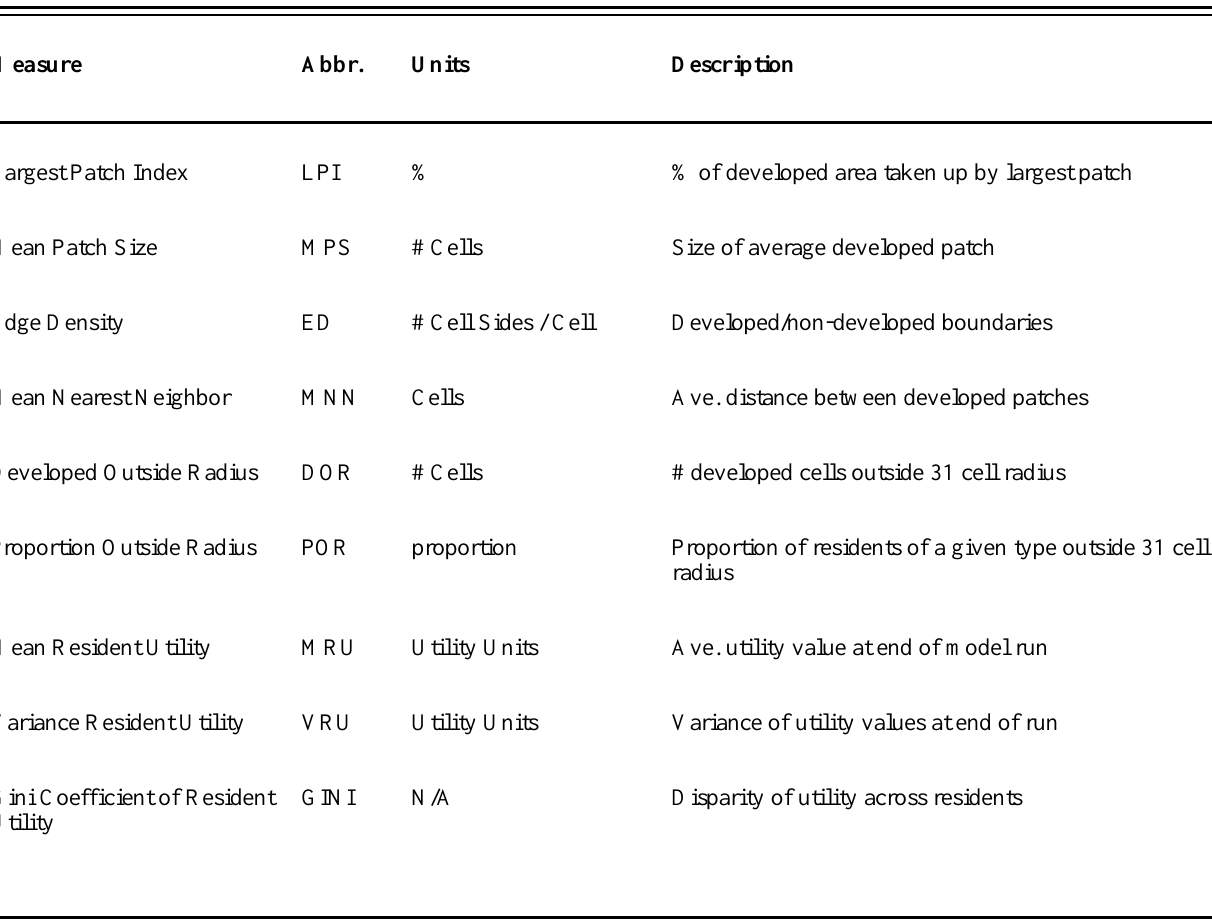
Table 3. Measures used to describe model